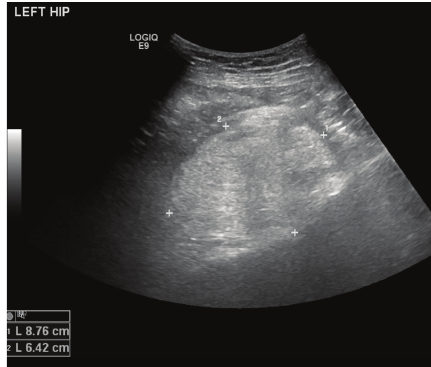
Figure 4: An ultrasound scan demonstrates a hyperechoic lesion, outlined by calliper markings. The homogenous echoic appearance is that of a fat containing lesion.